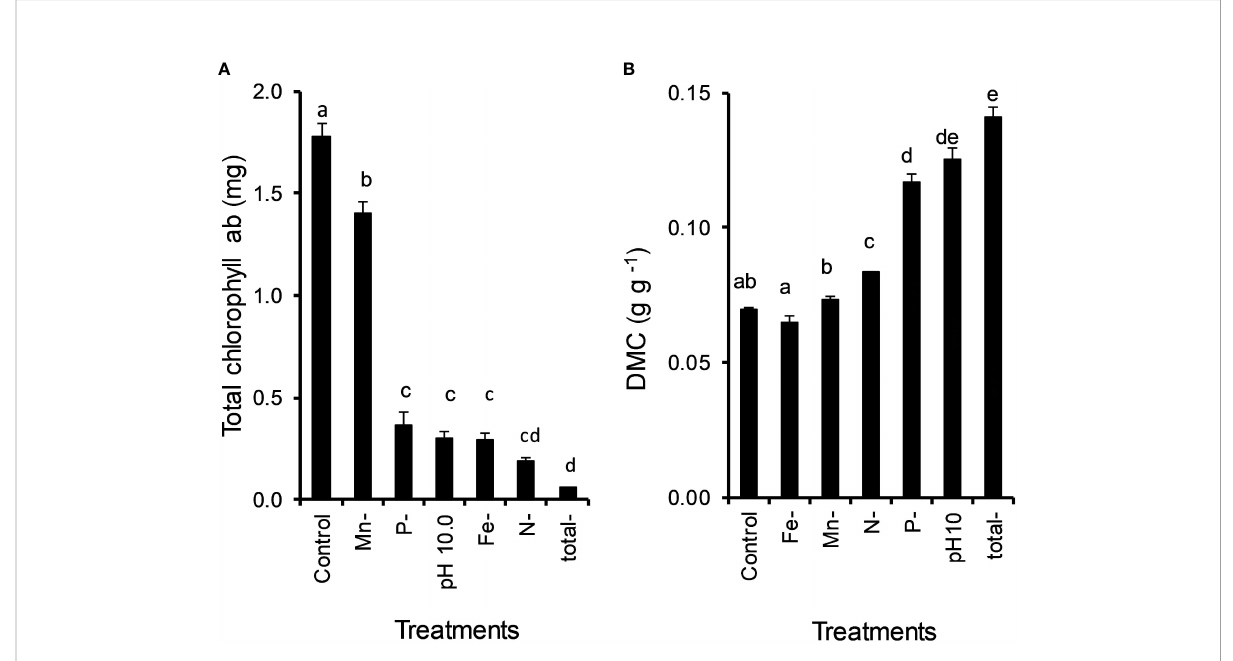
FIGURE 5 Effect of nutrient de fi ciencies (N, P, Fe, Mn) and high pH (10) caused by Ceratophyllum demersum on the total chlorophyll content (A) and dry matter content (DMC) (B) of Lemna gibba (means ± standard error, n = 4). Signi fi cant differences (oneway ANOVA, Tukey ’ s test, P < 0.05) among treatments are indicated with different lowercase letters.